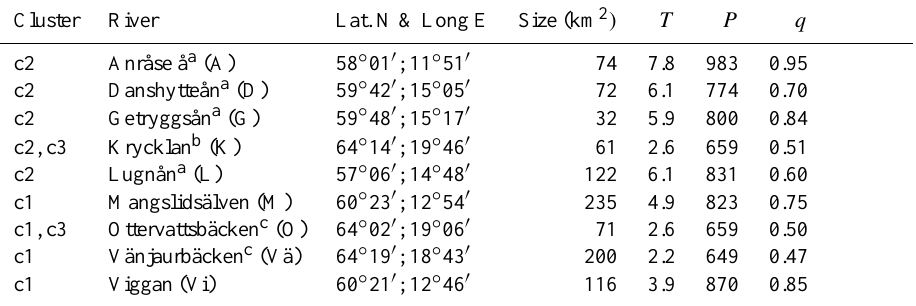
Table 1. Characteristics of the rivers. Cluster is the grouping of calibration and test sets used in the modelling. Air temperature ( T ◦ C) and specific discharge ( q mmday − 1 ) are the medians of daily values for 1990–2010, precipitation ( P mm) is the median of the yearly sum. P , T and q are modelled by SMHI, see Methods for more details.